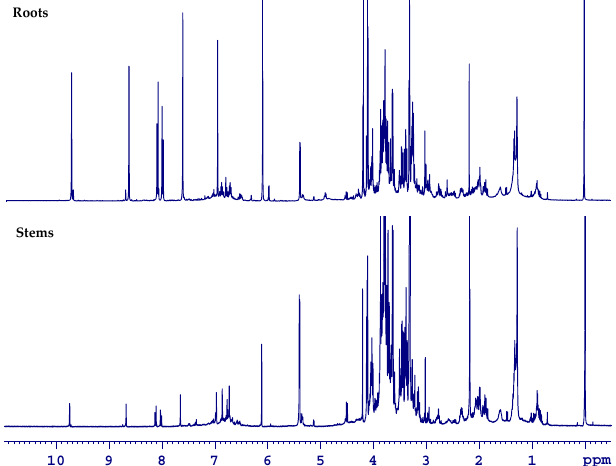
Figure 7. Comparative overview of 1 H HR-MAS NMR spectra ( ẟ − 0.50–11.00) from the roots and stems 1 H HR-MAS NMR spectra ( δ − 0.50–11.00) from the roots and parts of Berberis laurina (400 MHz, ~10 mg swollen in 40 µL CD 3 OD).